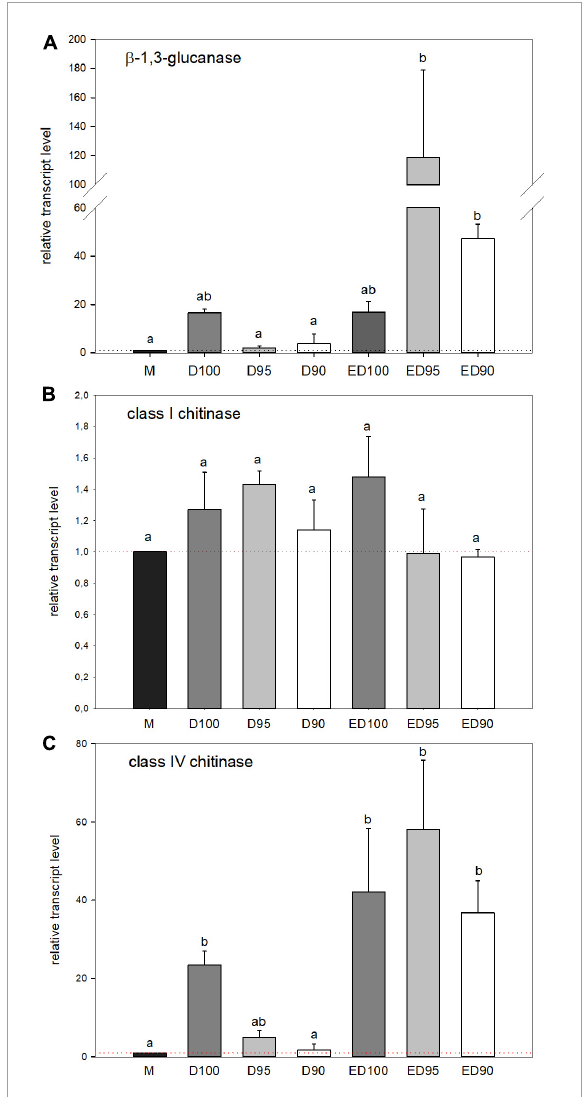
FIGURE10 Relative transcript level of β -1,3-glucanase (A) , class I chitinase (B) , and class IV chitinase (C) in mature embryos (M), control embryos at half (D100) and at the end (ED100) of treatment with 100% relative humidity, and embryos exposed to 95 and 90% relative humidity during the first half of desiccation (D95 and D90) and subsequently transferred to 100% relative humidity (ED95 and ED90). Transcript levels are compared relative to expression levels in mature embryos (value1). Values are expressed as means ± standard deviations ( n = 9). Different letters indicate a statistically significant difference at p ≤